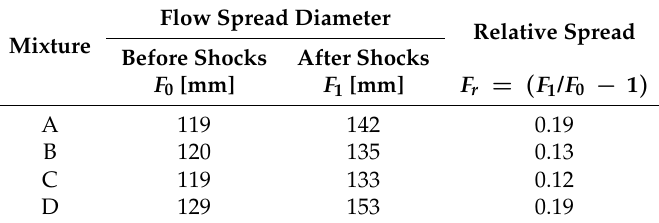
Table 2. Results of flow table tests at 20min after